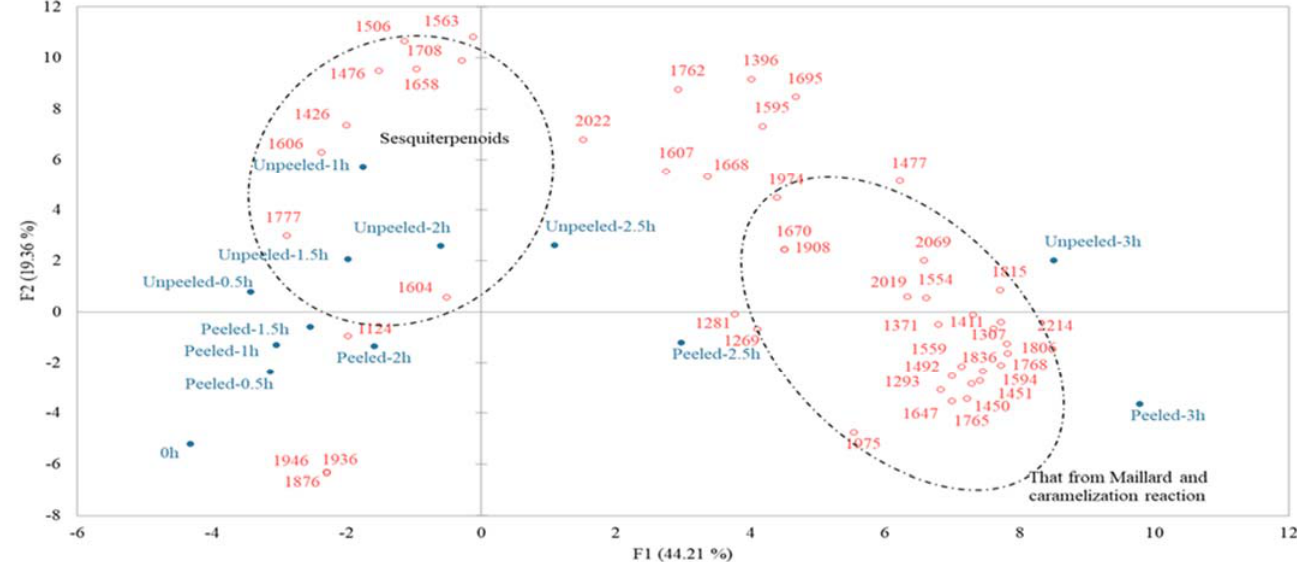
Figure 2. PCA plots of the volatile compound formation of sweet potato during roasting process; the hollow dots indicate the compounds responsible for the perceived aroma of sweet